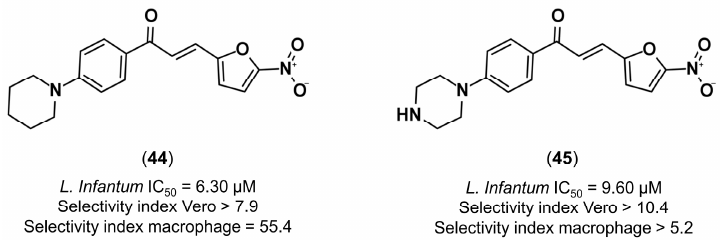
Figure 16. Anti-leishmanial 5-nitro-substituted heteroaryl chalcones identified by integration of pharmacophore screening and molecular docking studies [154]. pharmacophore screening and molecular docking studies